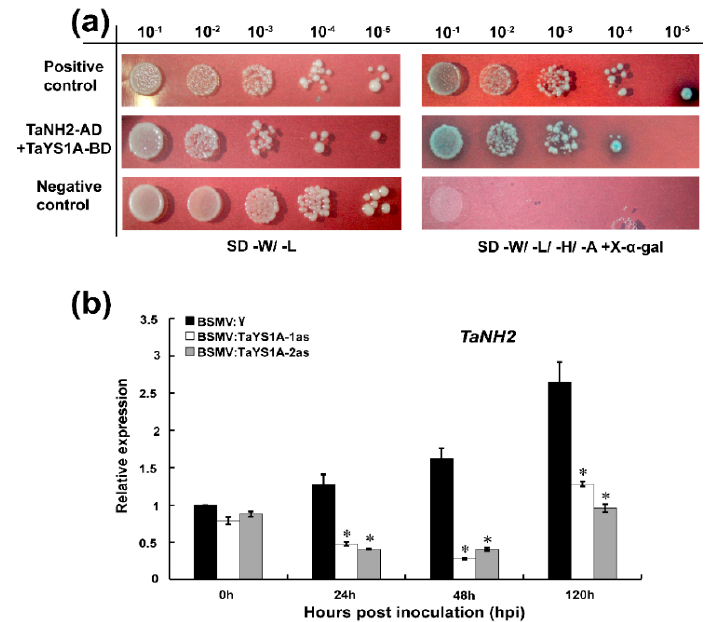
Figure 8. Interaction between TaYS1A and TaNH2. ( a ) Y2H interaction analysis between TaYS1A and TaNH2 in yeast. The constructed TaYS1A-BD interacts with TaNH2-AD in yeast. Cells of yeast strain AH109 containing the indicated pairs of plasmids were cultured on selective media SD-W/-L or SD- W/-L/-H/-A (SD/-Trp/-Leu or SD/-Trp/- Leu/-His/-Ade containing 20 µg/mL X- α -gal). Plates were photographed 3 dpi. SD, synthetic dropout growth medium. ( b ) Silencing of TaYS1A suppresses the transcription of TaNH2 . Relative expression of TaNH2 in TaYS1A -silenced leaves inoculated with CYR23 was determined by qRT-PCR. The qRT-PCR was used to analyze the relative expression of all genes. The comparative threshold (2 −ΔΔ CT ) approach was used to measure the relative transcript levels of TaYS1A . Data normalized with the transcription of wheat elongation factor, TaEF-1 α , and visualized as fold change compared to control at 0h. BSMV: γ infected wheat leaves were used as a control. Values represent the mean ± standard errors of three independent biological samples. Asterisks ( p < 0.05) designate significant differences from BSMV: γ by the Student’s t -test. To determine whether the silencing of TaYS1A affected the expression of TaNH2 , we further analyzed the transcript level of TaNH2 in TaYS1A -silenced plants by qRT-PCR. We found that the expression of TaNH2 was significantly downregulated in the TaYS1A -silenced plants infected with CYR23 compared to the control plants (Figure 8b) 4. Discussion The YSL-protein-family plays a key role in plants, particularly in the mobilization and long- distance transportation of micronutrients. YSL proteins were also found to be affected by the SA level and involved in the host defense against pathogens [38,62]. To date, the metal transportation ability of YSLs has been identified and characterized in different plant species, including Arabidopsis , rice, maize, and Brachypodium [63–65] . However, the biological functions of YSL proteins in pathogen induced defense are largely unknown, particularly in wheat defense against Pst infections. In our present study, we cloned a wheat YSL subfamily gene, TaYS1A , and characterized its molecular function during wheat- Pst interaction. The expression of TaYS1A was strongly induced when inoculated with Pst avirulent race CYR23 and SA treatment. Silencing of TaYS1A enhanced the susceptibility to both avirulent and virulent Pst races. The reduced expression of PR- genes and SA accumulation suggests that TaYS1A exhibits a positive role in wheat resistance to Pst . YSLs are members of the OPT family, representing the largest subgroup of transmembrane proteins that are mainly involved in the transfer of a wide variety of substrates [31]. In wheat, a total of 26 genes of the YSL subfamily were previously identified. Most of the YSL genes were predicted to be plasma-membrane localized proteins, whose expressions were induced under Fe-limited